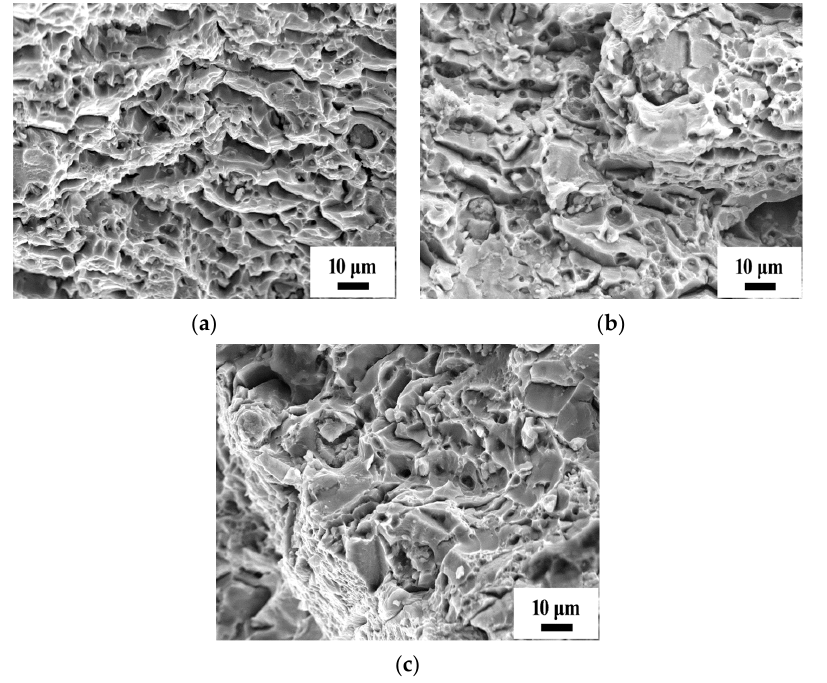
Figure 8. Tensile fracture morphology of alloys in solid solution + aging at − 10 °C: ( a ) solution + aging 18 h; ( b ) solution + aging 24 h; ( c ) solution + aging 36 h.